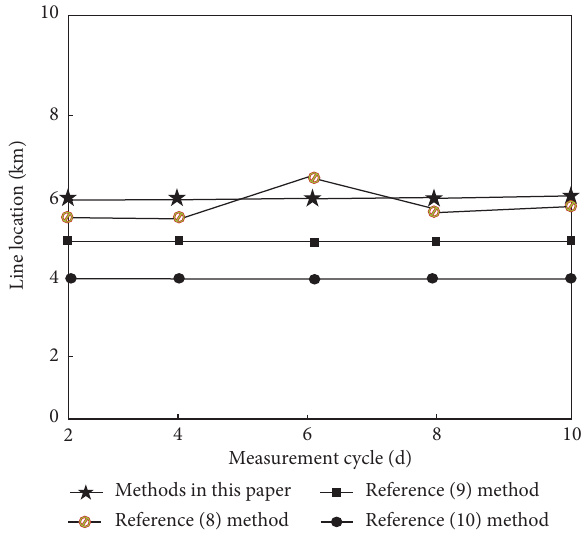
Figure 6: IEEE 14 node anomaly detection identifcation results.